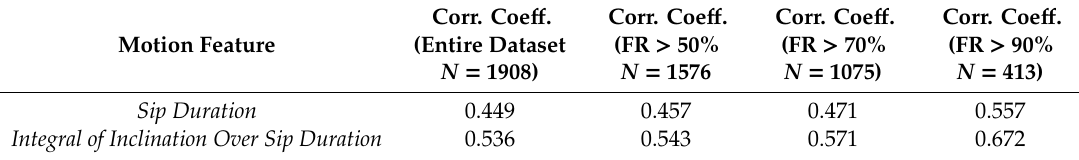
Table 3. Correlation between previously reported motion features and volume for various fill ratio (FR)